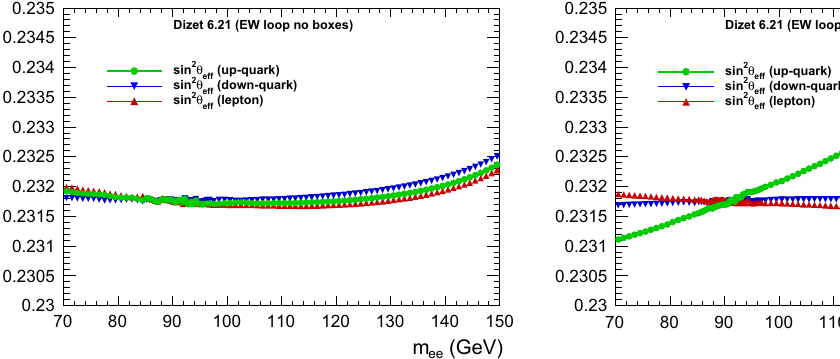
( s , t ) as a function of Fig. 6 Effective weak mixing angles sin 2 θ f ef f m ee and cos θ = 0, without (left-hand plot) and with (right-hand plot) box corrections. The K f ( s , t ) form-factor calculated using Dizet Table 7 From the Dizet library printout: effective weak ) . For mixing angles and α( M 2 Z